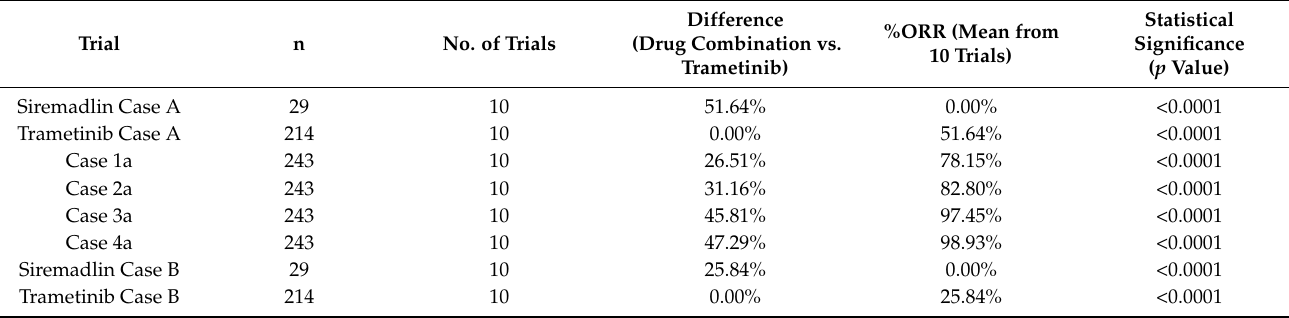
Table 5. Comparison of estimated efficacy of siremadlin and trametinib combination at the 120 and 2 mg doses assuming various case